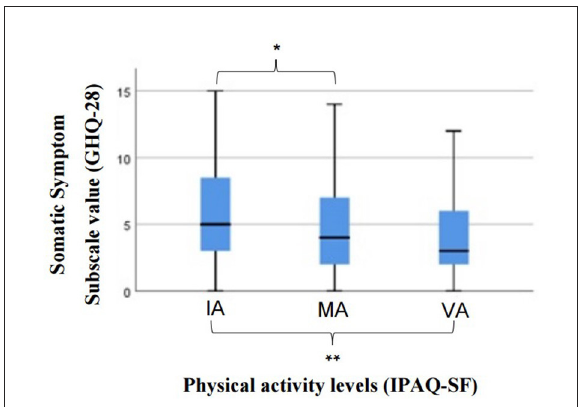
FIGURE1 Results of the Kruskal-wallis test for the comparison of somatic symptoms among the physical activity levels. GHQ-28, General Health Questionnaire-28; AI, Insufficiently Active; MA, Moderately Active; VA, Vigorously Active; PA, Physical Activity; IPAQ-SF, International Physical Activity Questionnaire; *Significant differences between the category IA and MA individuals ( p = 0.012); **Significant differences between IA and VA individuals ( p = 0.005).